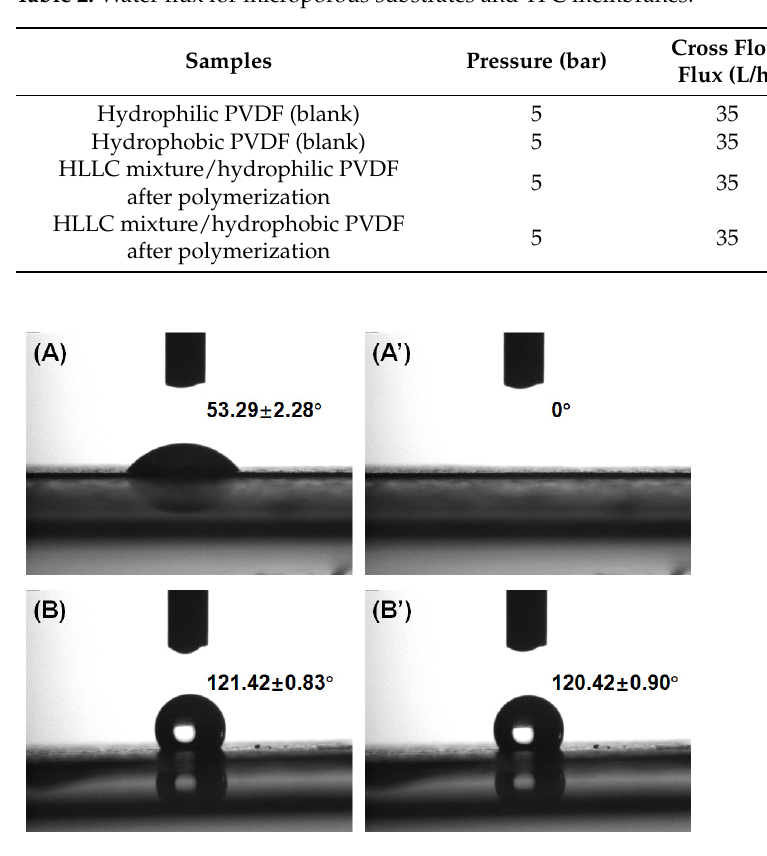
Figure 4. Contact angle results for ( A ) hydrophilic and ( B ) hydrophobic PVDF after 1 s; ( A’ ) hy- drophilic and ( B’ ) hydrophobic PVDF after 1 min.